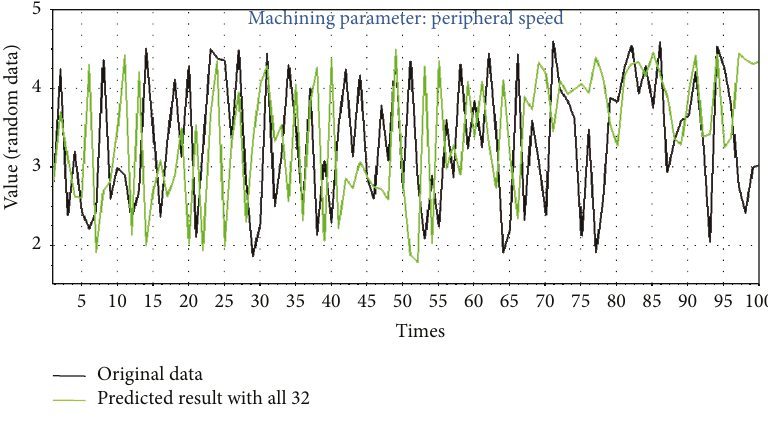
Figure 23: Predicted results of peripheral speed of grinding wheel.